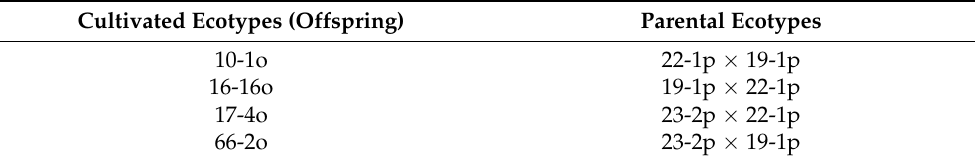
Table 7. Origin of cultivated ecotypes and their corresponding parental ecotypes. Cultivated Ecotypes